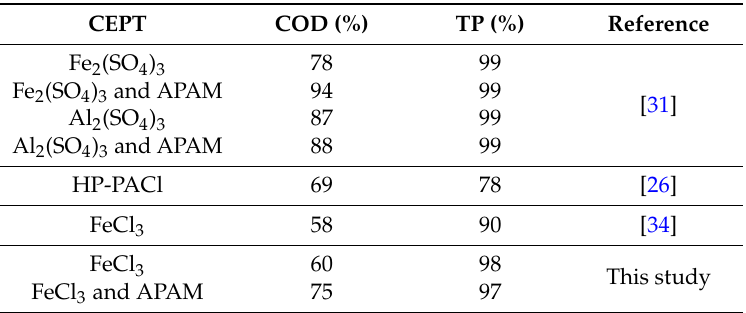
Figure 3. Effect of FeCl 3 + APAM dosing on anaerobic digestate treatment (FeCl 3 = 40 mg/L). Table 3. The comparison of CEPT’s